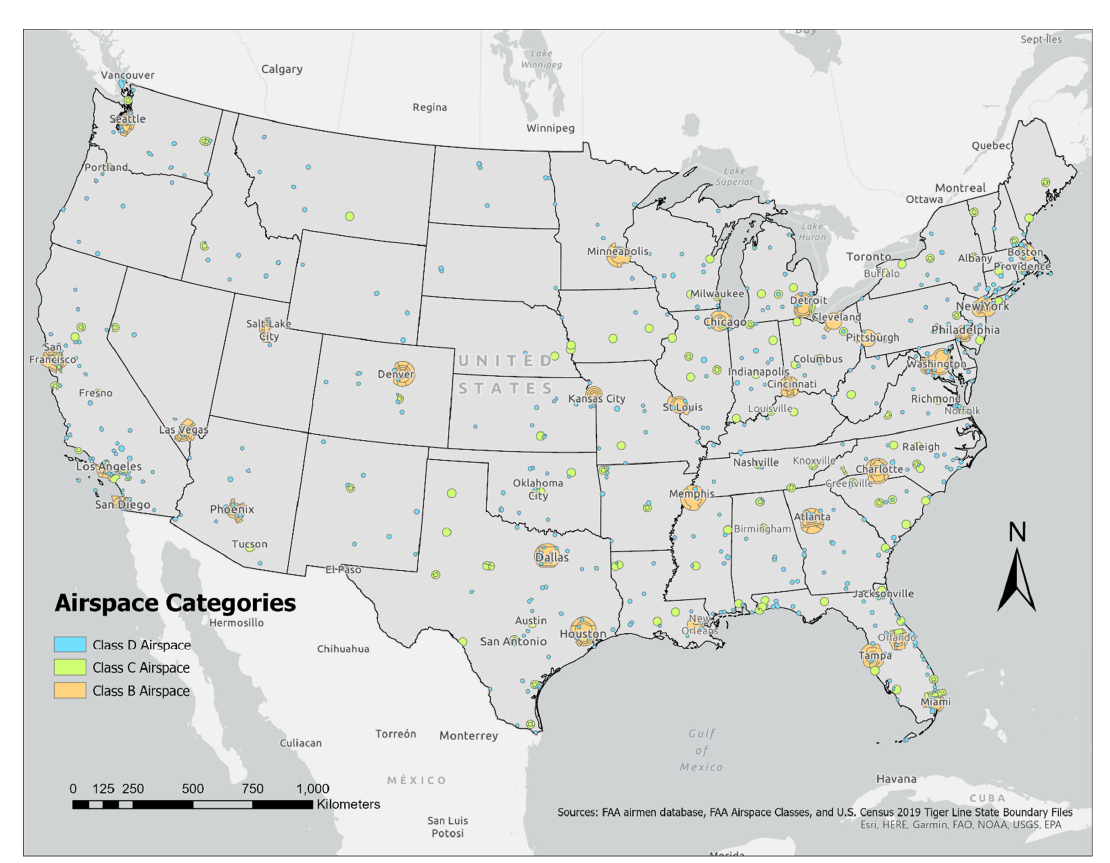
Figure 3. Airspace classes D, C, and B within the continental United States. Table 2. List of pilot point location data layers generated by attribute query and